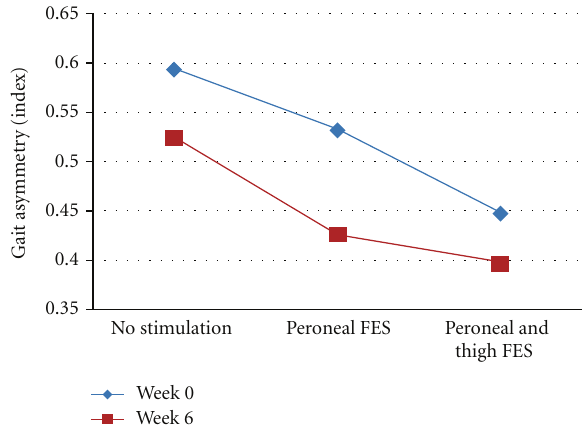
Figure 2: E ff ects of FES on gait asymmetry.